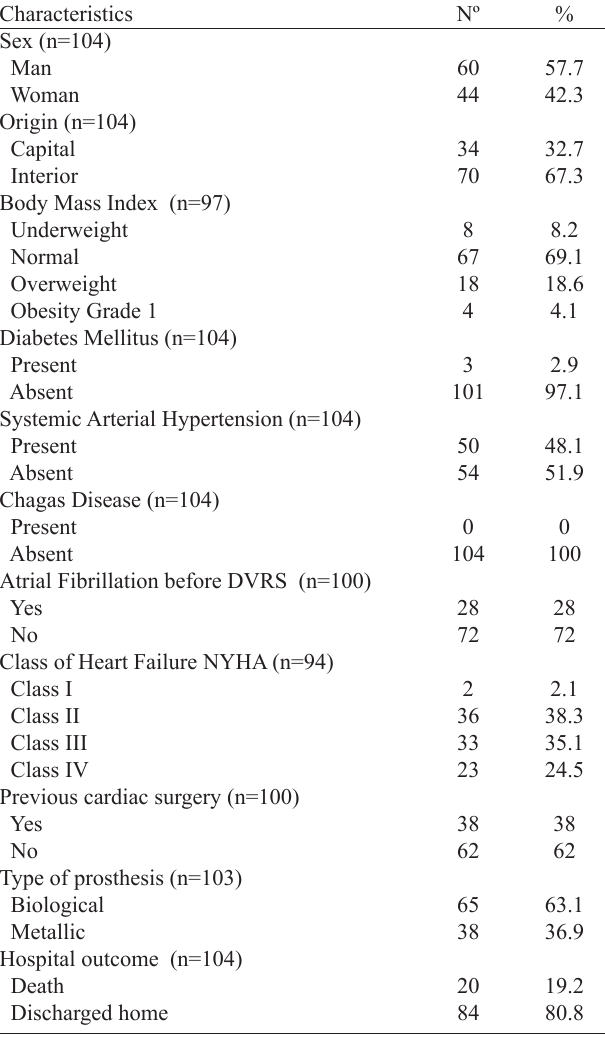
Table 1. Clinical and epidemiological characteristics of the study population. Salvador,